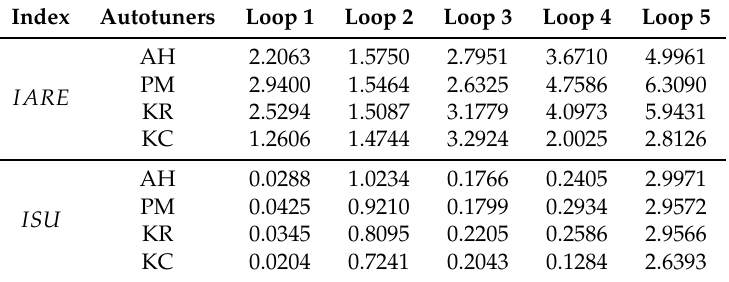
Table 5. Performance indexes for IARE and ISU .